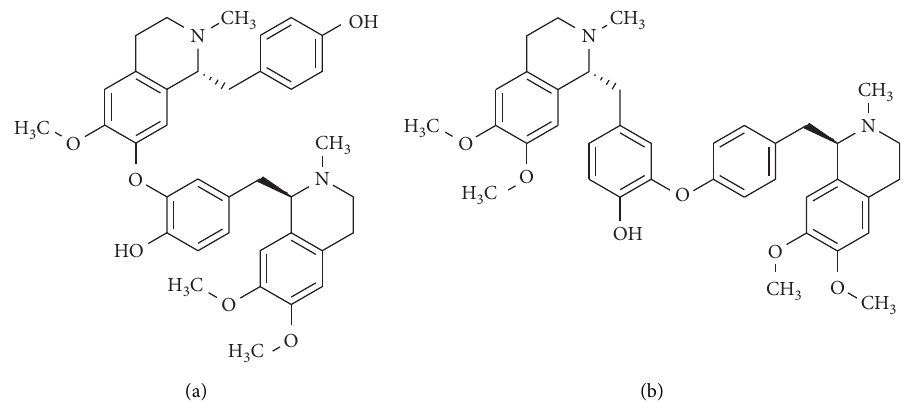
Figure 1: Chemical structure of (a) liensinine and (b)